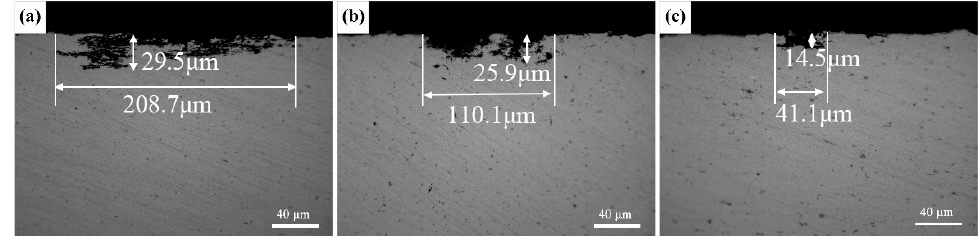
Figure 7. Intergranular corrosion morphologies (ED – TD plane) of alloys with different Zn/Mg ratios: ( a ) 1# alloy; ( b ) 2# alloy; ( c ) 3# alloy.